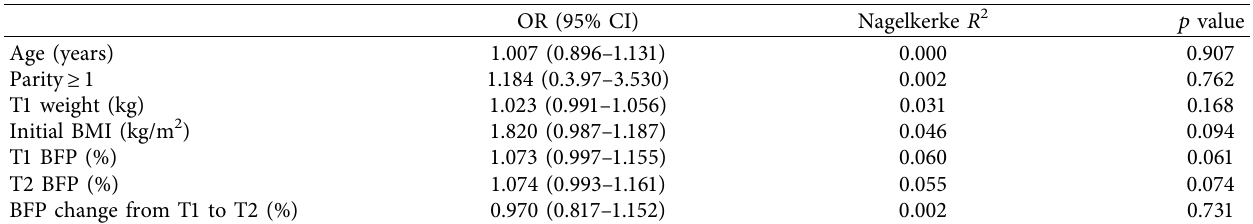
Table 6: Univariate logistic regression analysis for the association between BIA body composition and GDM.